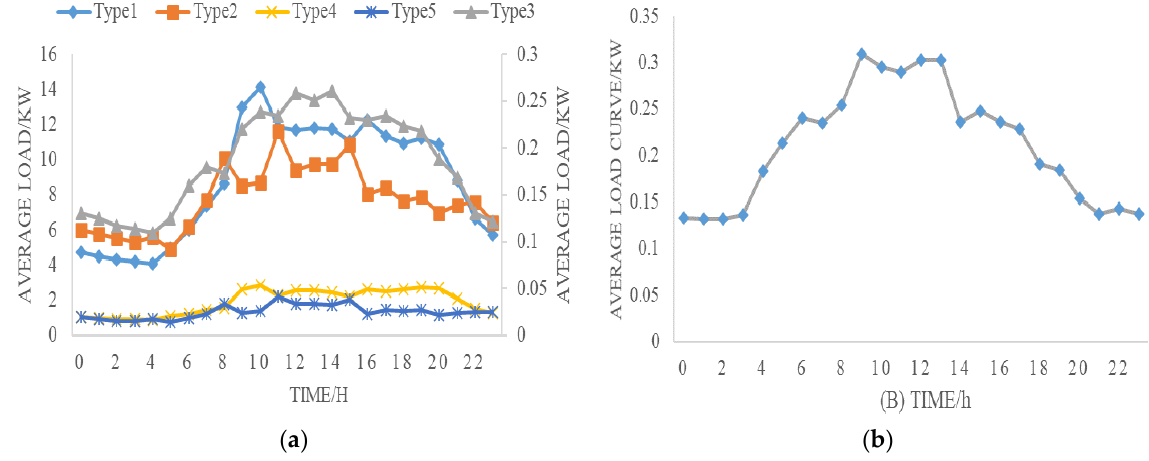
Figure 6. The load curve in May ( a ) clustered 5 types of loads; ( b ) the type 3 load.